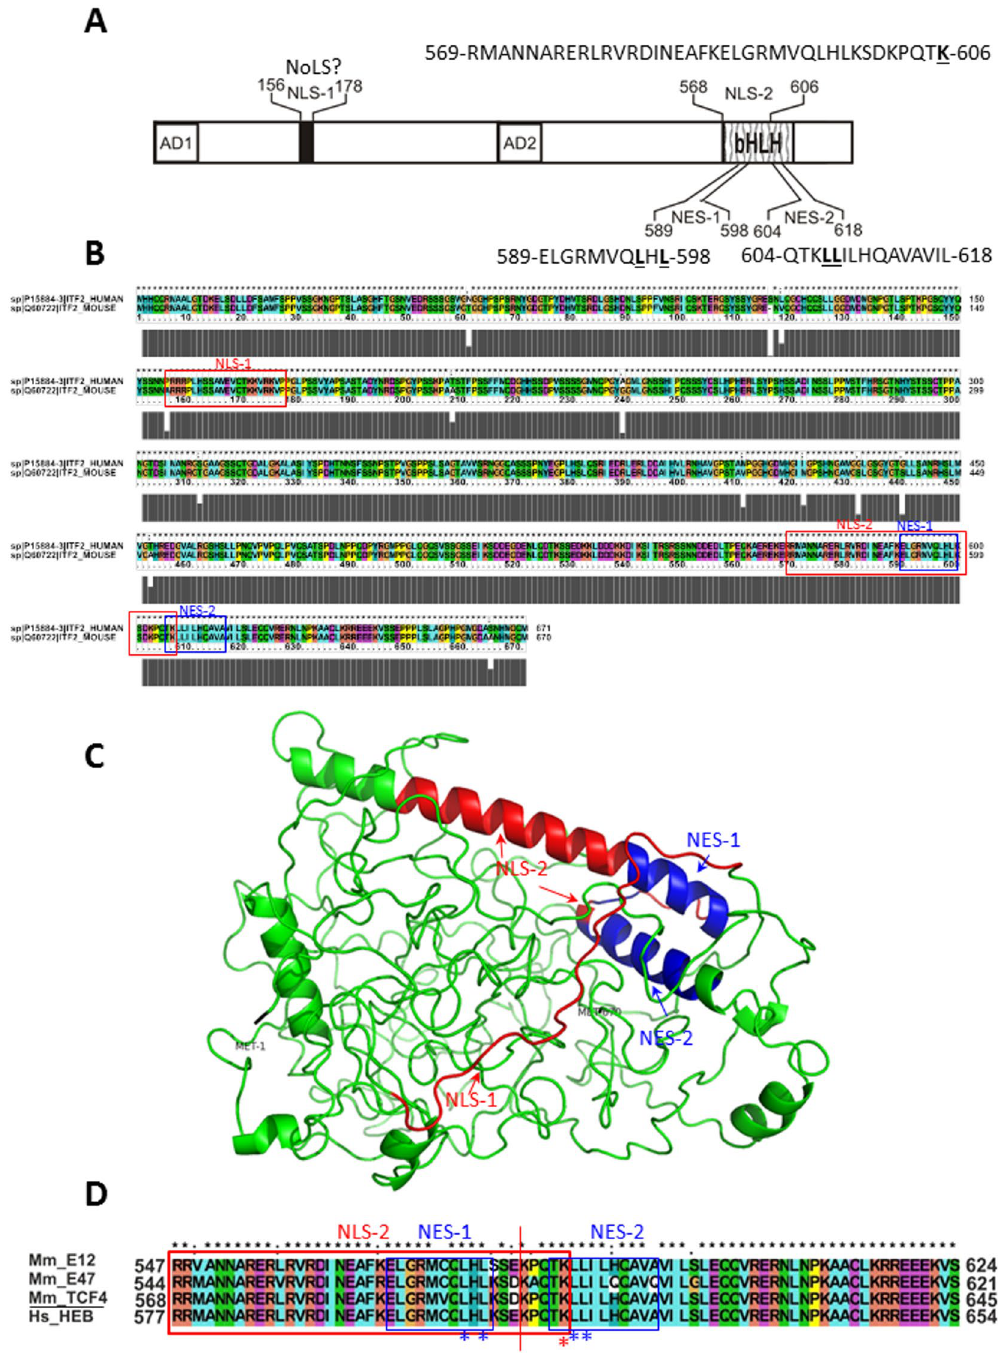
Figure 11. ( A ) Summary of NLSs and NESs in TCF4. Schematic representation of NLSs and NESs residing within the TCF4 protein structure. ( B ) Result of protein sequences alignment of TCF4-B + isoforms of mouse and human TCF4 with ClustalX showing the conservation of TCF4 between these organisms. ( C ) Model of TCF4 generated by Phyre2. 113 residues (17% of protein) encompassing mainly the bHLH domain (aa 567- 620) of TCF4 were modelled with a confidence higher than 90% using the templates: c2mh0A, c5c3lA, c2ql2A and c2ypbB. Remaining 601 residues (89%) of TCF4 lacking any template and predicted as disordered were modelled by ab initio. NLS-1 and NLS-2 are shown in blue. NES-1 and NES-2 are shown in red. ( D ) ClustalX sequence alignment of TCF4/568-645 region encompassing NLS-2, NES-1 and NES-2 in the bHLH domain with corresponding sequences of E12 (aa 547-624), E47 (aa 544-621) and HEB